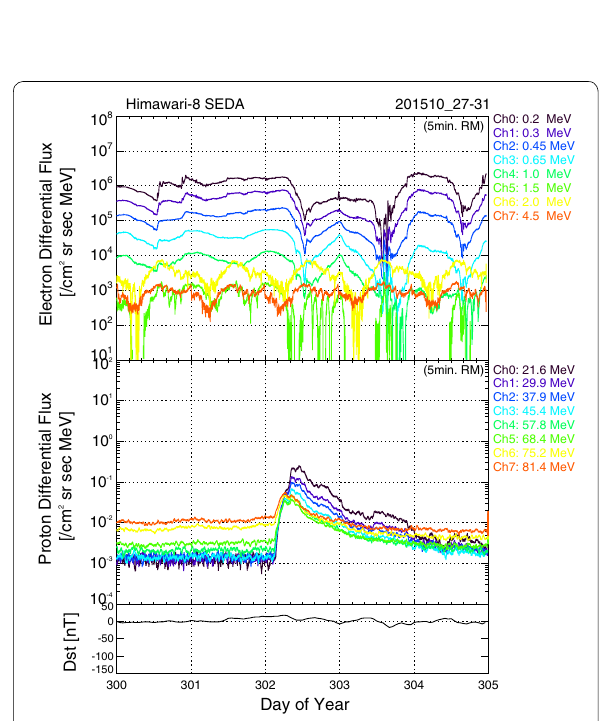
Fig. 3 Himawari-8/SEDA observations on October 27–31, 2015. The format of the plot is the same as that in Fig.